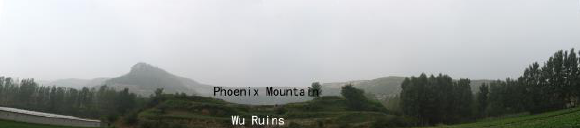
Figure 7. The topographic map of Huangyue